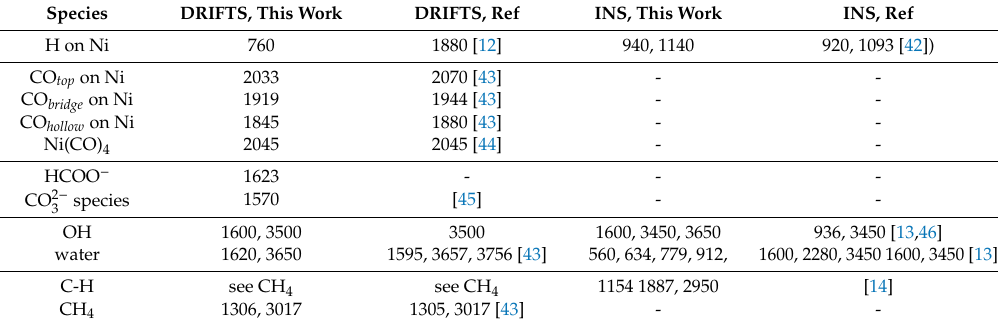
Table 1. Main hydrogen-, carbon- and oxygen-based vibrations as detected by DRIFTS and INS, all in cm − 1